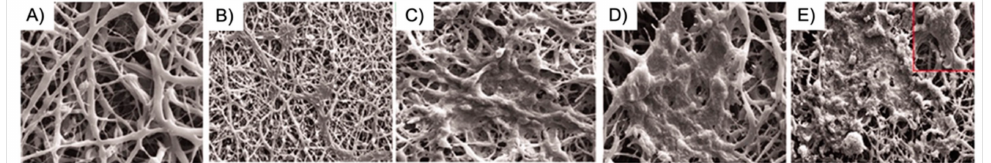
Figure 8. Three-dimensional electron micrograph images of ( A ) unseeded hybrid PLLA/PCL scaf- folds, ( B ) hiPSCs-seeded scaffold on starting day, ( C ) induction cells to assembling, ( D ) induced cells to aggregate, and ( E ) islet-like clusters. Scale bars are ( A ): 10 mm; ( B – E ): 100 mm [106]. Reprinted with permission from Taylor &